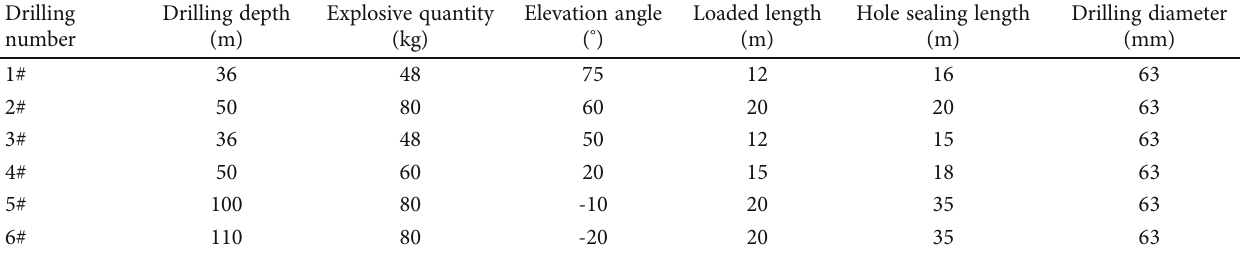
Table 2: Roof pressure relief parameters of working face.